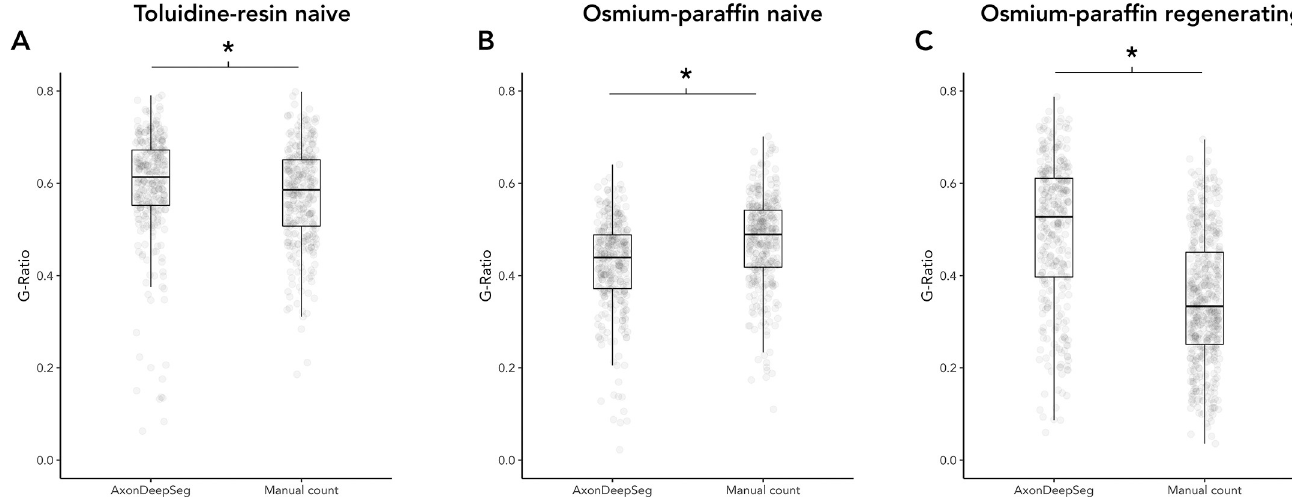
Fig 7. Comparison of g-ratio measured by ADS or manually. (A) Na ï ve nerves, toluidine-resin protocol, mean g-ratio for all micrographs for both nerves. (B) Na ï ve nerves, osmium-paraffin protocol, mean g-ratio for all micrographs for both nerves. (C) Regenerating nerves, osmium-paraffin protocol, mean g-ratio for all micrographs for both nerves. Asterisk ( � ) = significant (P < 0.05 by two-sample t-test). Boxes are 1 interquartile range (IQR), whiskers 1.5 � IQR.